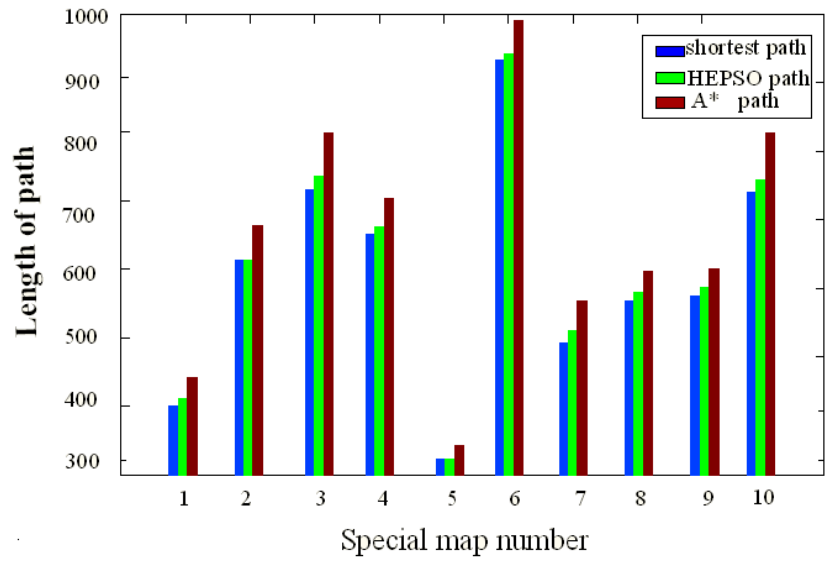
Figure 6. Comparison of path lengths on distinct maps of A* and HEPSO algorithms.